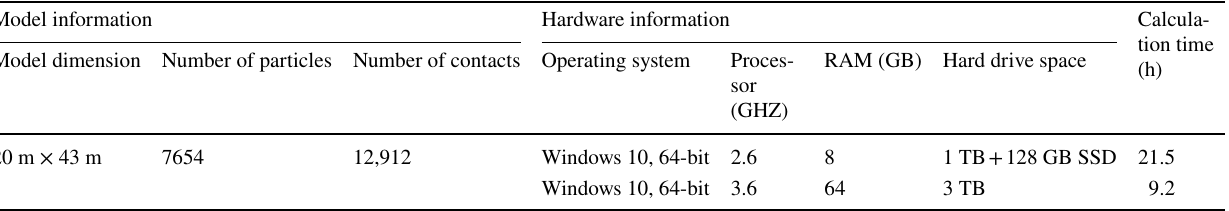
Table 4 Model/hardware information and calculation time Model information Hardware information Calcula-